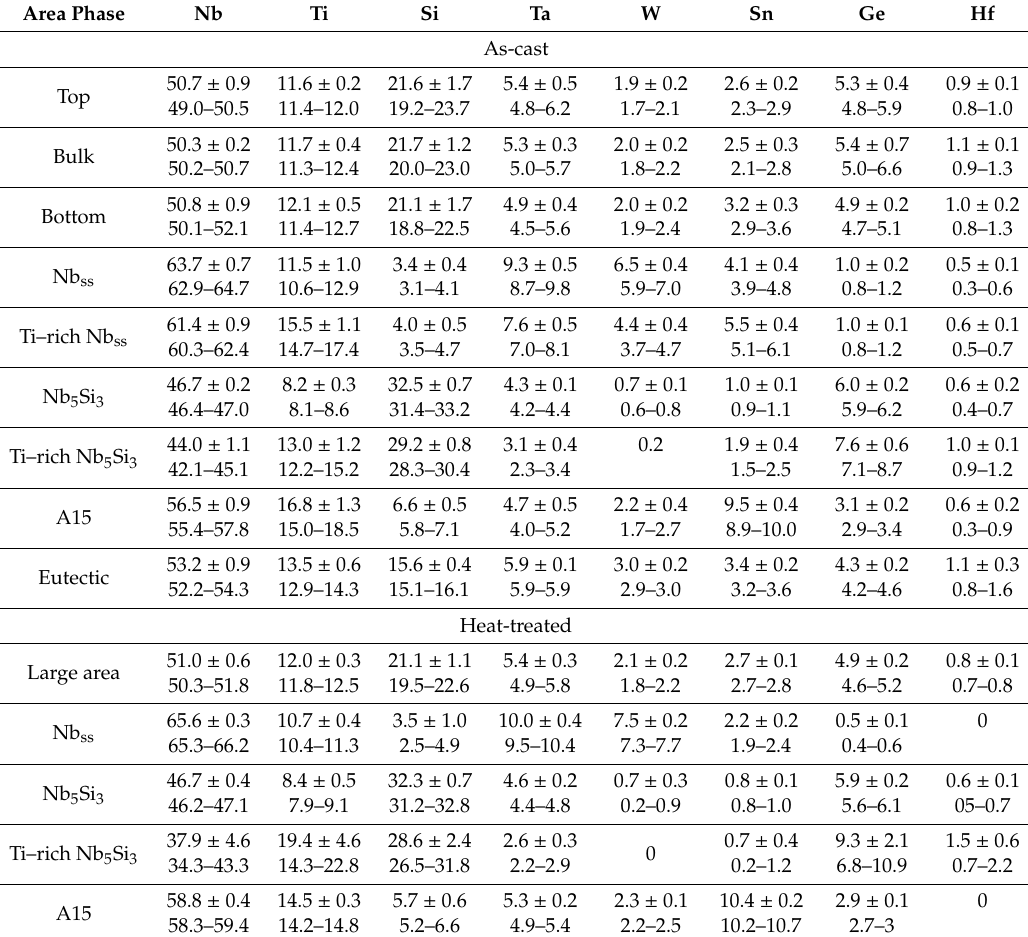
Table 3. The analysis data (at.%) for the alloy